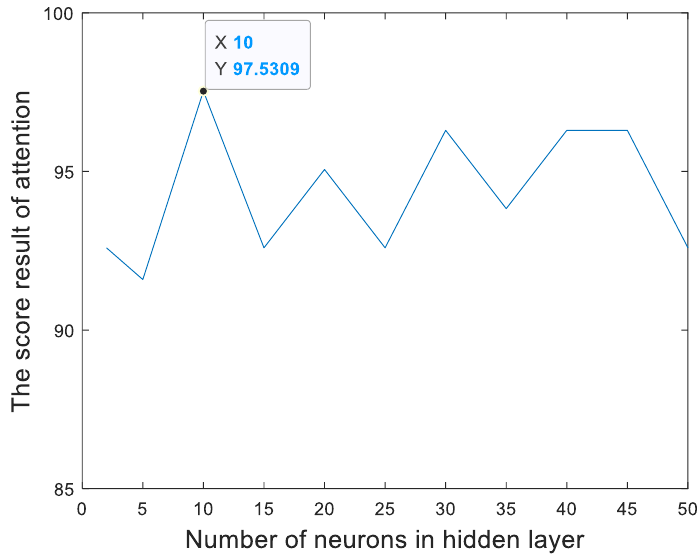
Figure 14. The relationship between the percentage of the classification accuracy and the total number of neurons in the hidden layer of the BP neural network in our proposed method trained using the EEGs acquired from Hejian performing the reading activity under the concentration state on the second day.